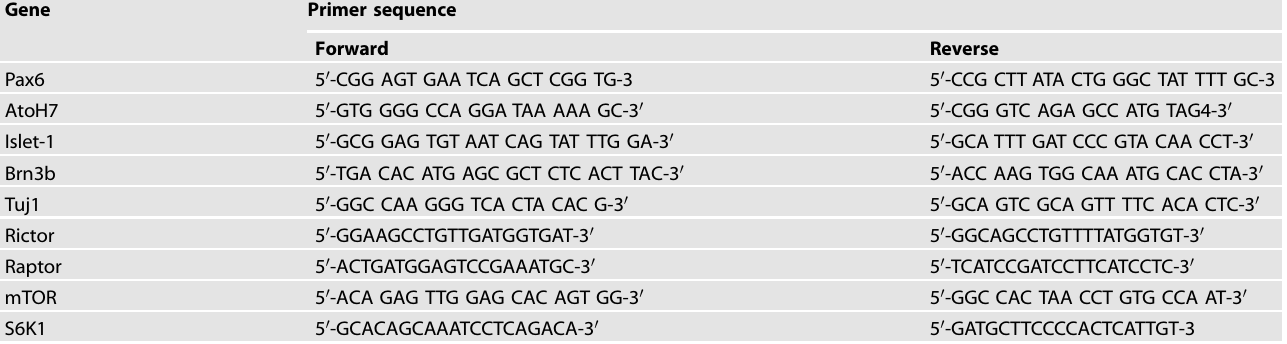
Table 1. List of primers used for quantitative RT-PCR.